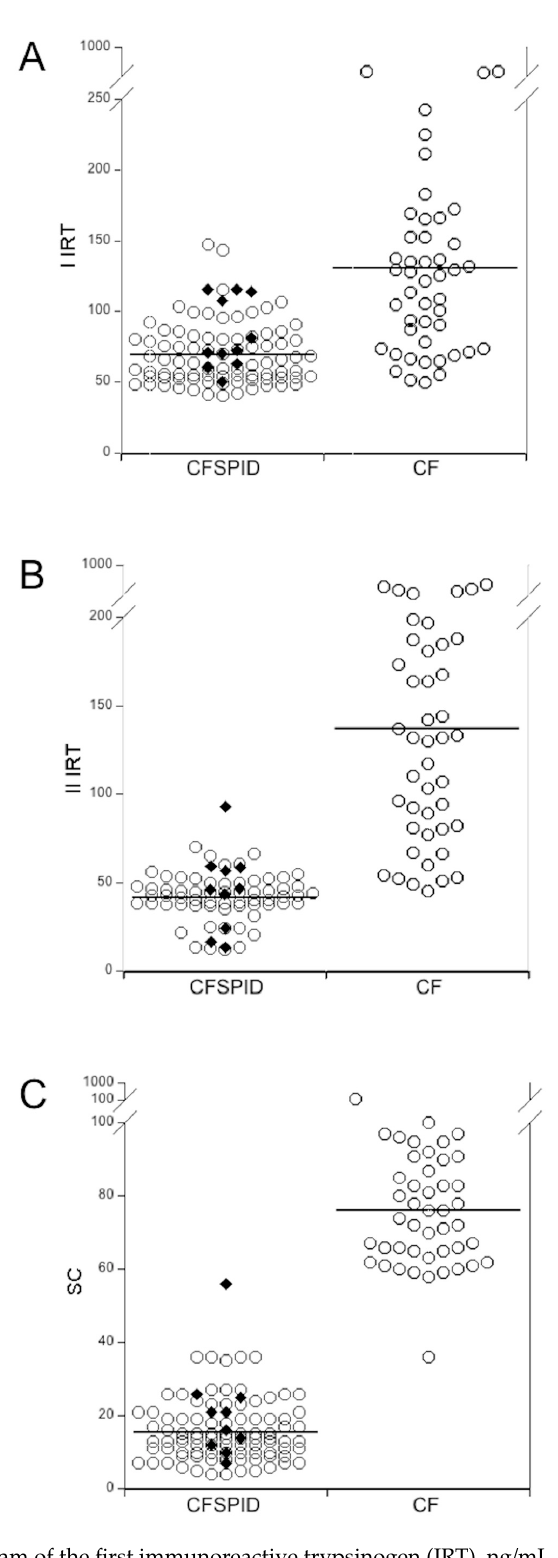
Figure 1. ( A ) Scattergram of the first immunoreactive trypsinogen (IRT), ng / mL. ( B ) second IRT, ng / mL and ( C ) and sweat chloride (SC), mmol / L in patients with CF and in subjects with CF-SPID at the newborn period. Among the subjects with CF-screening positive inconclusive diagnosis (CF-SPID), the black diamonds represent the cases evolved to cystic fibrosis transmembrane conductance regulator (CFTR)-related disorders (CFTR-RD) or to